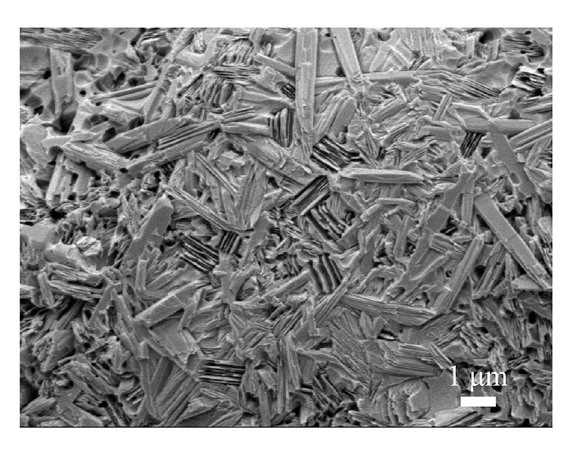
FIGURE 8 The SEM image of LD glass-ceramics treated by optimal heat treatment scheme (sample